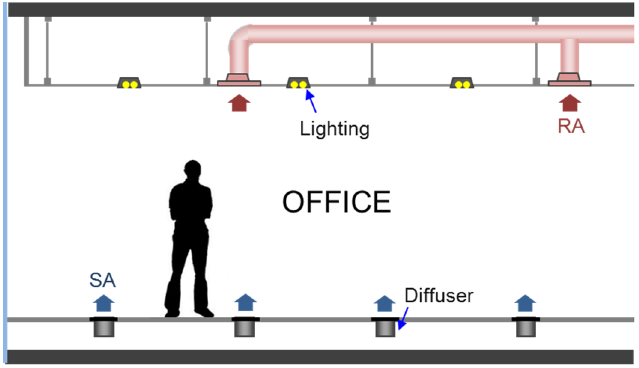
Figure 3. Under-floor air distribution system